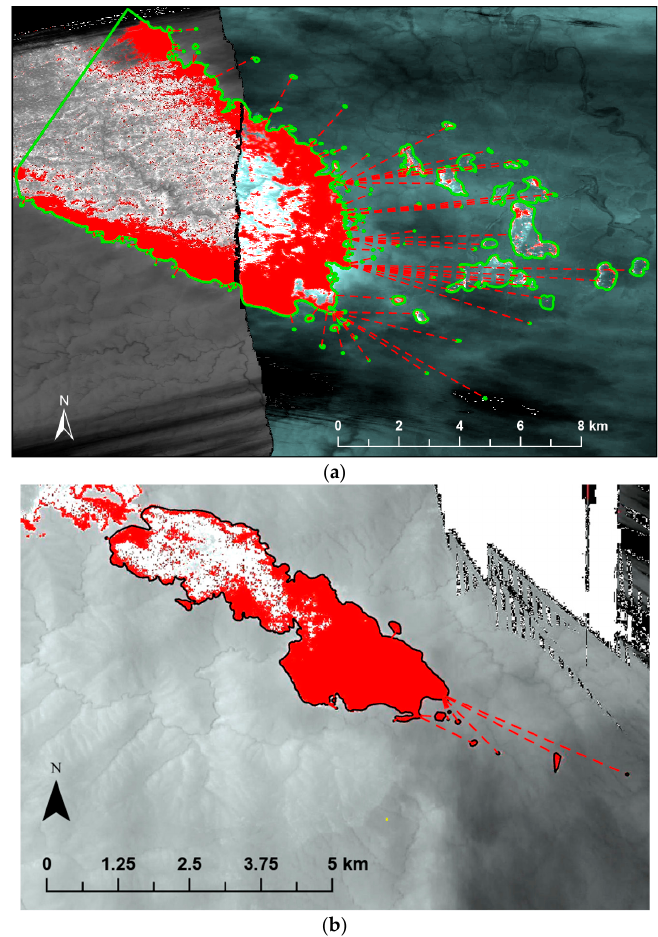
Figure 4. Department of Environment, Land, Water, and Planning (DELWP) line scan examples. Actively burning fire is processed to show as red. White is recently burnt, light to dark greys are unburnt vegetation. Black areas are dense parts of the smoke plume or cloud. Red dashed lines indicate spot-fire distance measured for analysis. The largest polygons represent source fire, the smallest polygons are spot fires (green in ( a ), black in ( b ). ( b ) has some larger spot fires in grassland. See other examples in Storey et al. [3] .